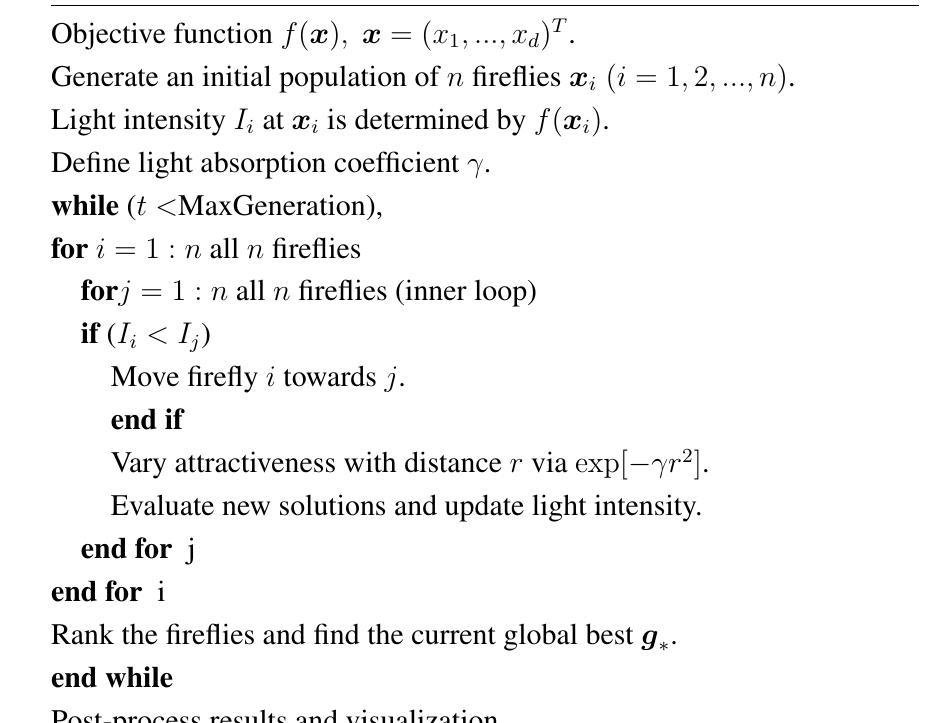
Figure 1. Pseudocode of the Firefly Algorithm